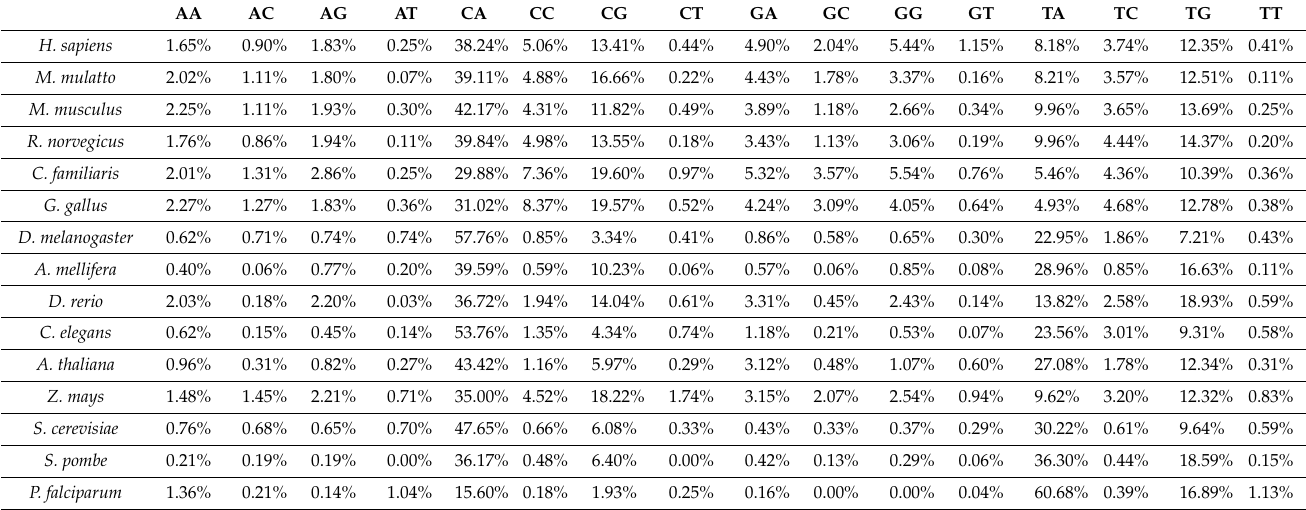
Table 3. The content (percentage) of each of 16 dinucleotides in positions − 1,